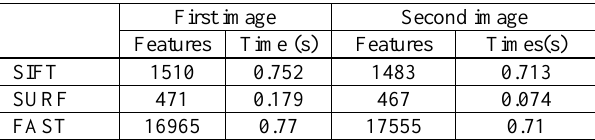
Table 2. Processing time comparison.